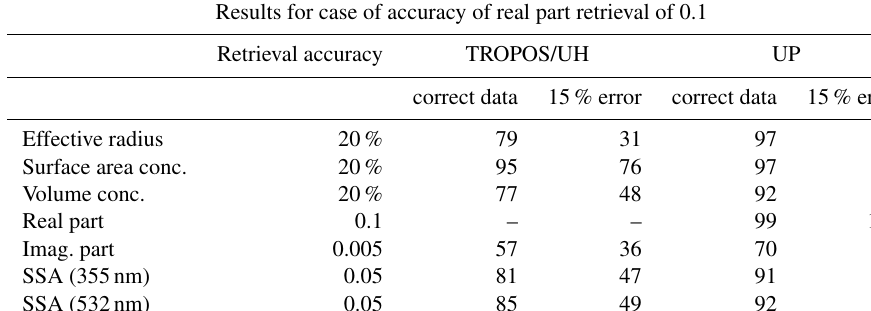
Table 3. Percentage of simulation cases that result in given retrieval accuracy. Results for case of accuracy of real part retrieval of